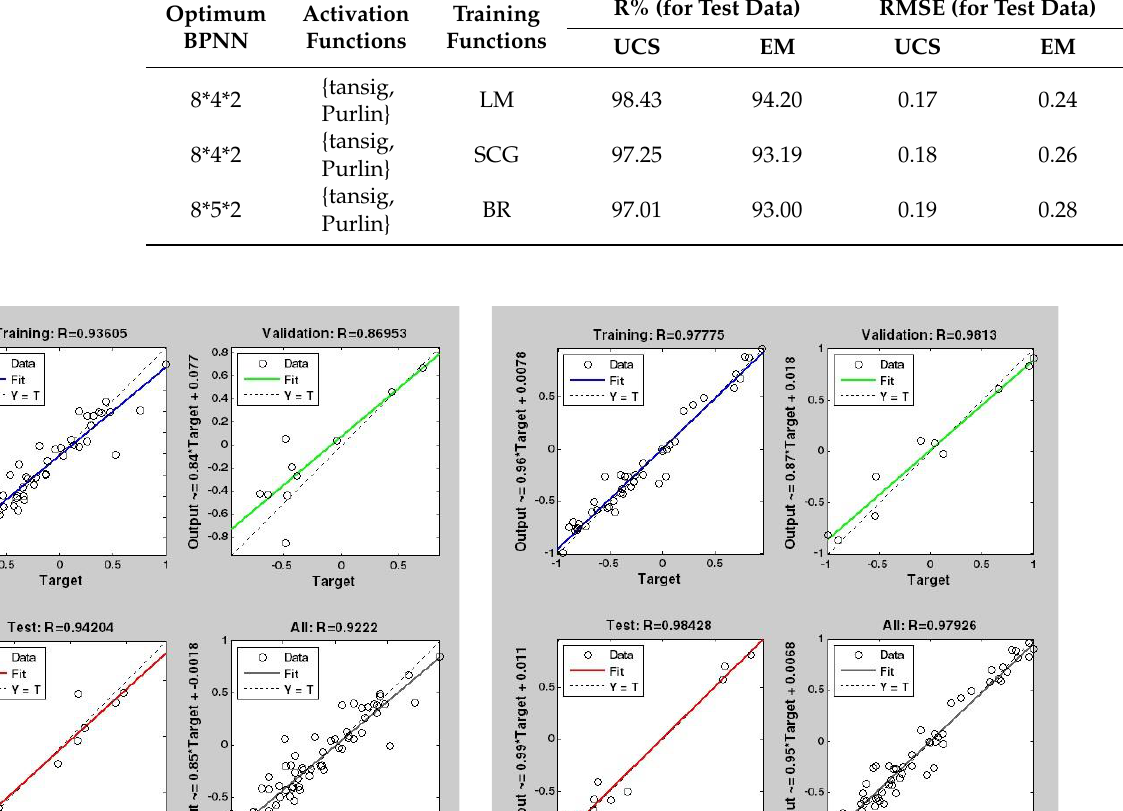
Table 6. BPNN results using LM, BR, and SCG training functions. Optimum Activation BPNN Functions